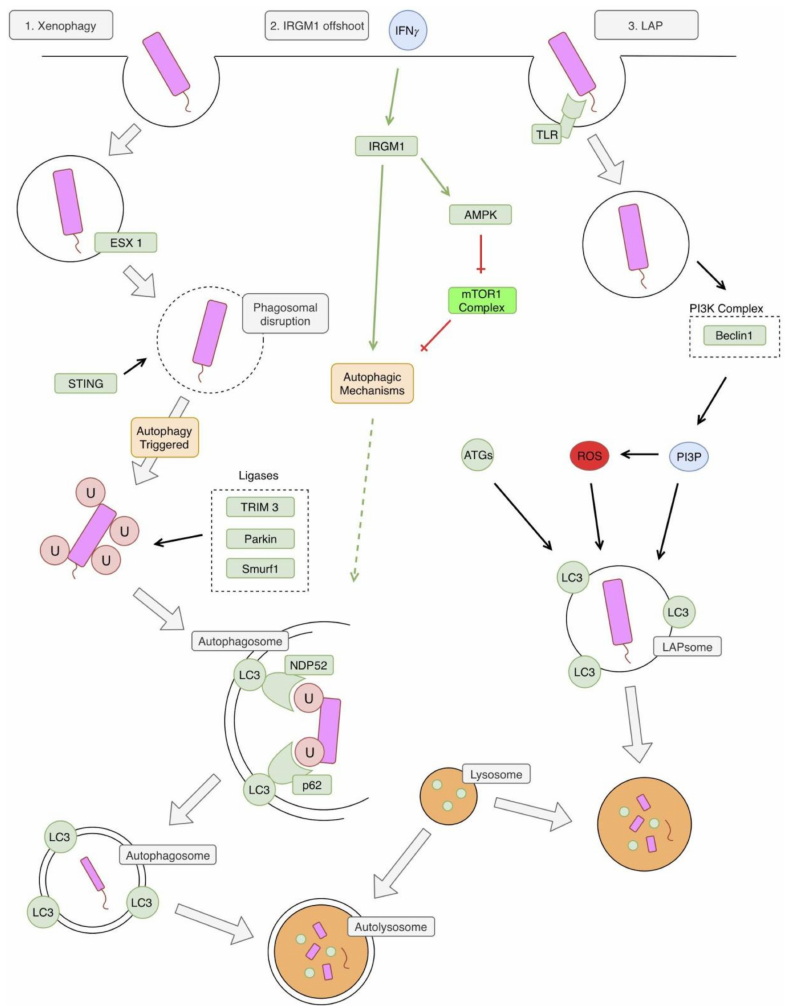
Figure 2. Autophagy and Mycobacterium tuberculosis ( Mtb ). The first pathway illustrated in the classic xenophagy pathway. The phagosome is disrupted by bacterial early secretory antigenic target (ESAT)-6 secretion system (ESX1). This allows for recognition of bacterial DNA by the stimulator of interferon genes (STING) pathway, which triggers autophagy. Several ligases are involved in the ubiquitination of the bacteria, including Tripartite motif-containing protein 3 (TRIM3), Parkin, and Smurf1. This ubiquitination facilitates recognition of the bacteria by autophagic mechanisms, leading to the formation of a double-membraned autophagosome. This autophagosome fuses with a lysosome leading to the formation of an autolysosome and the degradation of bacteria. A second pathway, and an offshoot of the first xenophagy pathway, involves immunity-related p47 guanosine triphosphatase family M protein 1 (IRGM1). IRGM1 is triggered by interferon-gamma (IFN- γ ) and leads to the activation of autophagic mechanisms. The specifics of this pathway are unclear, but it might involve activation of adenosine monophosphate (AMP)-activated protein kinase (AMPK), which relieves the autophagy pathway of its inhibition by mTOR1. The third and final pathway is also referred to as the 1A/1B-light chain 3 (LC3) associated phagocytosis (LAP) pathway. Bacteria is recognized by a toll-like receptor (TLR) and phagocytosed. This process triggers the phosphoinositide 3-kinase (PI3K) complex, leading to the production of PI3P. PI3P leads to the production of reactive oxygen species (ROS), via stabilization of the nicotinamide adenine dinucleotide phosphate hydrogen (NADPH) oxidase-2 (NOX) complex. Phosphatidylinositol 3 phosphate (PI3P), ROS, and other autophagy related proteins (ATGs) lead to the formation of a LAPsome, which is a single-membraned compartment. Microtubule-associated protein 1A/1B-light chain 3 (LC3) is conjugated to the LAPsome, which triggers fusion with a lysosome, leading to degradation of the bacteria. NDP52: nuclear domain 10, protein